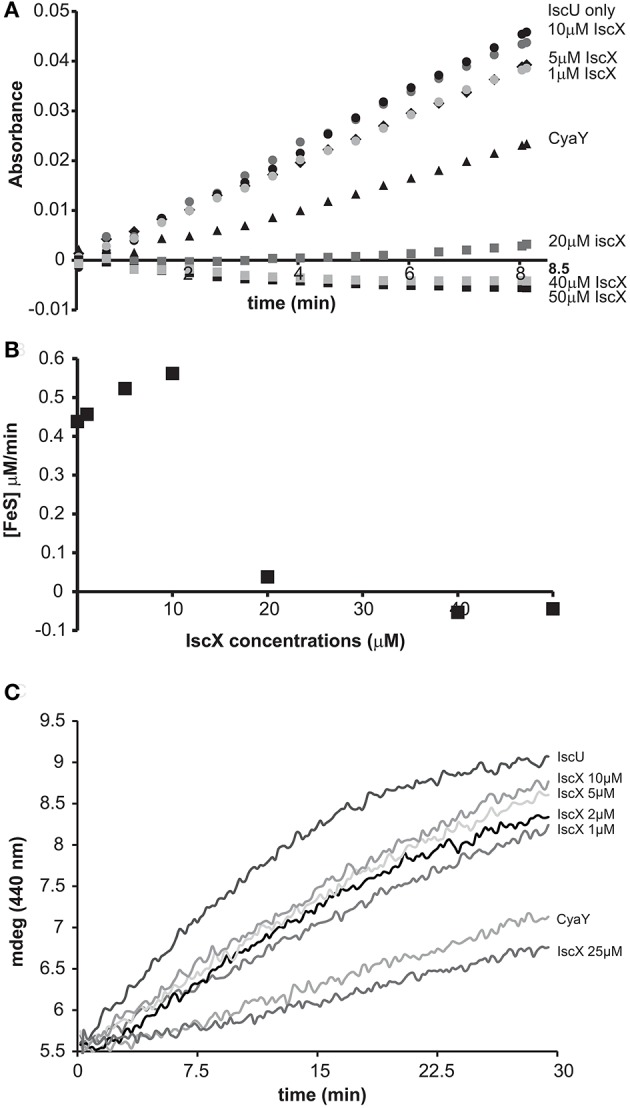
Effect of increasing concentrations of IscX on the enzymatic kinetics of Fe-S cluster formation on IscU. (A) Kinetics of cluster formation at increasing concentrations of IscX as measured by absorbance at room temperature. (B) Plot of the initial rates at increasing concentrations of IscX. Negative values are due to imperfect subtraction from the baseline and should be considered as zero (full inhibition). Only the initial part of the kinetics for each IscX concentration point was considered. The slope of these linear regions (for each IscX concentration) was used as the initial velocity. A molar extinction coefficient of 10.5 mM−1 cm−1 was assumed to convert the absorbance in concentration of Fe-S cluster produced. (C) Kinetics followed by CD. The assays were carried out using 1 μM IscS, 50 μM IscU, 250 μM Cys, 2 mM DTT, and 25 μM Fe2+ and increasing concentrations of IscX as indicated. For comparison, the experiment was also repeated in the presence of 5 μM CyaY. The error bars are not shown for sake of clarity but were typically within 5% or less.